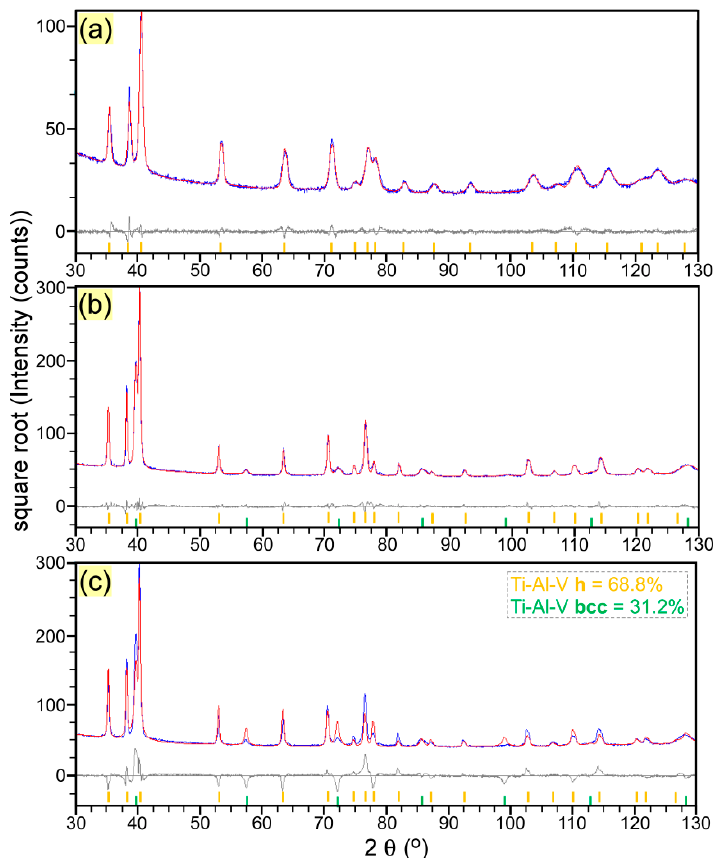
Figure 7. Experimental (blue) and simulated (red) XRD patterns and difference curves (gray) of the source powder fitted with Pawley method ( a ) and LMD printed Ti6Al4V fitted with Pawley ( b ) and Rietveld ( c ) methods. Orange sticks = α -phase; Green sticks = β -phase.